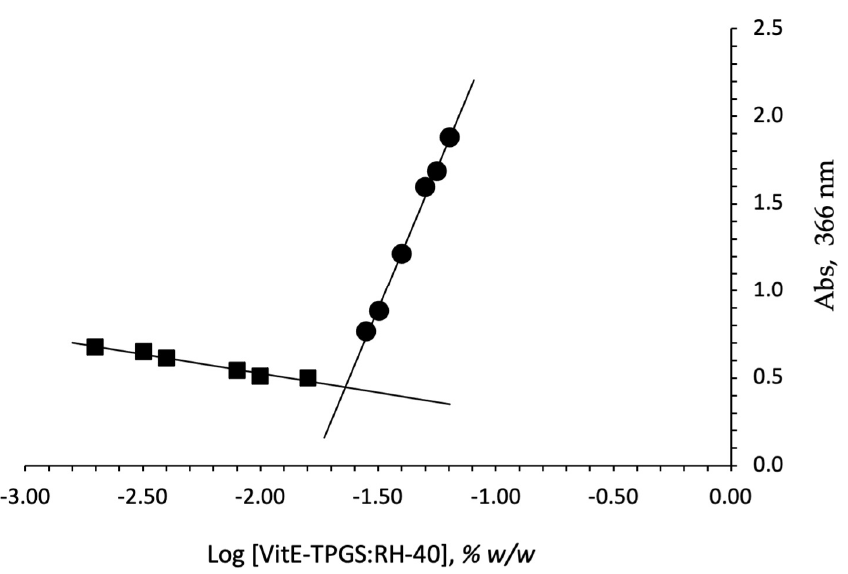
Figure 1. Plot of concentration of the surfactant VitE-TPGS:RH-40 (1:1 ratio) mixture vs. absorbance detected at 366 nm.